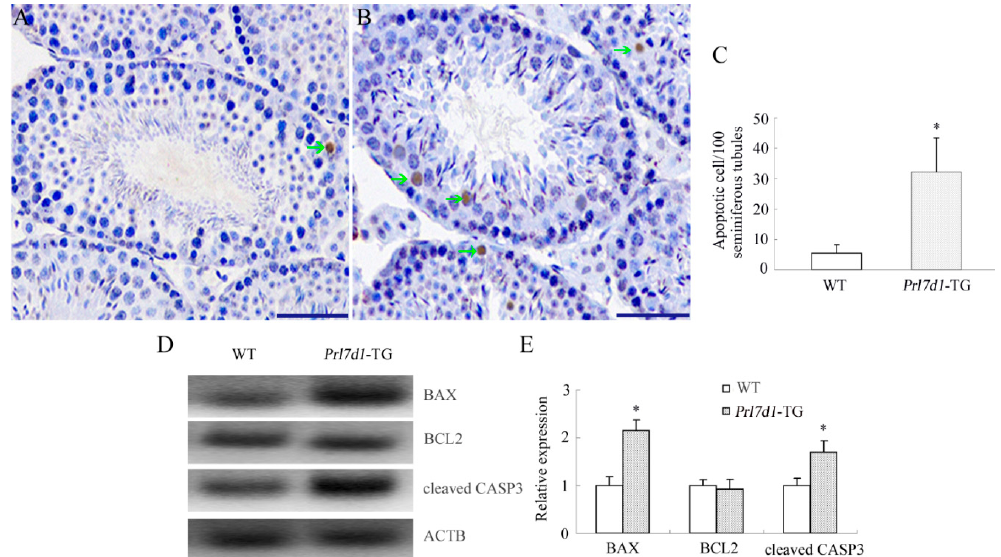
Figure 3. PRL7D1 overexpression results in increased germ cell apoptosis and upregulated